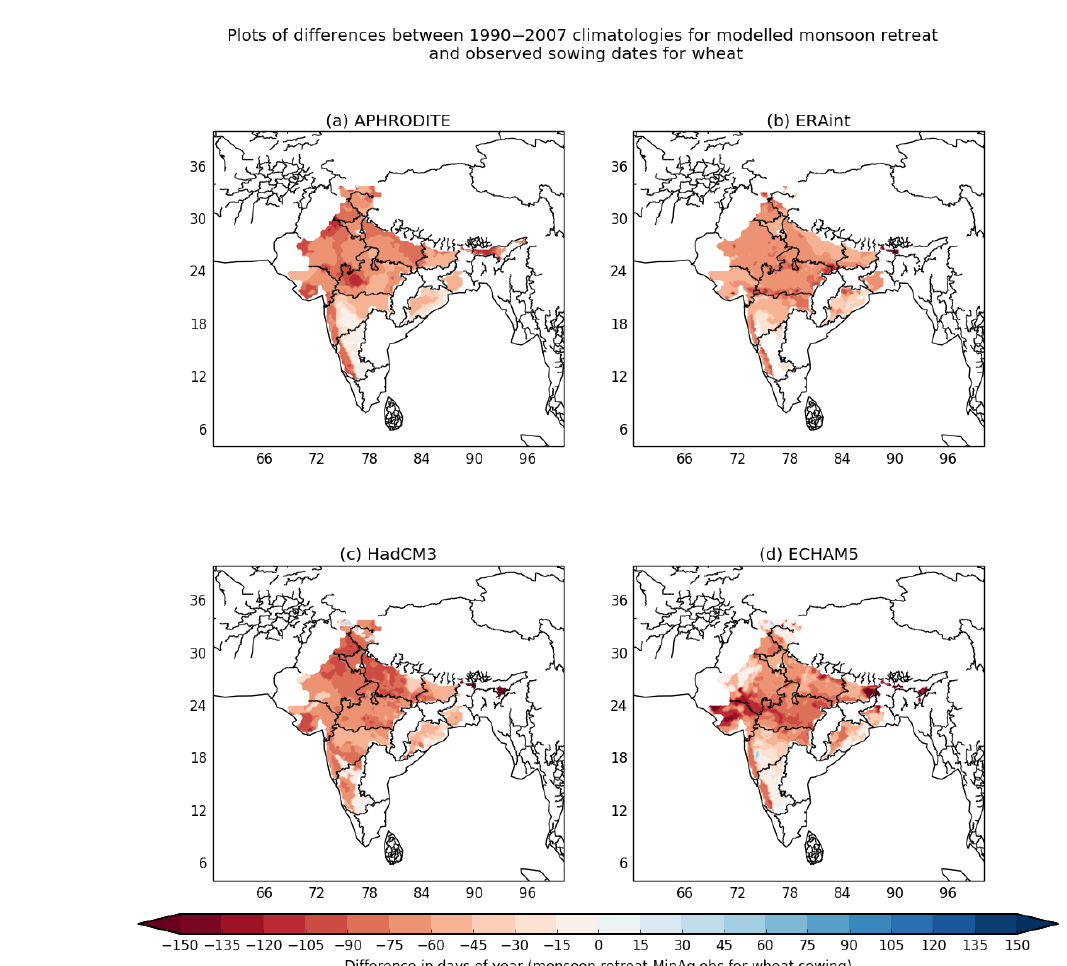
Figure B2. The difference between the midpoint of the monsoon retreat in the model and the midpoint of the observed wheat sowing period for